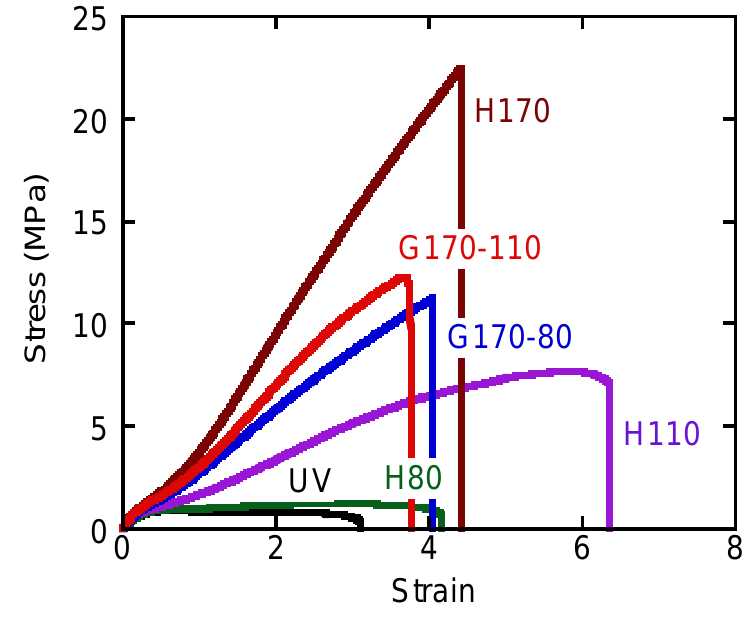
Figure 3. Stress – strain curves. Figure 3. Stress–strain